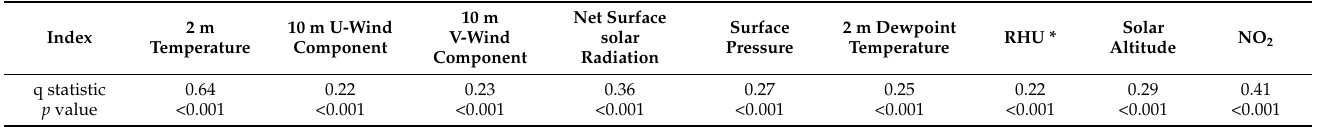
Table 1. Statistics of impact factor detection by geodetectors for ozone